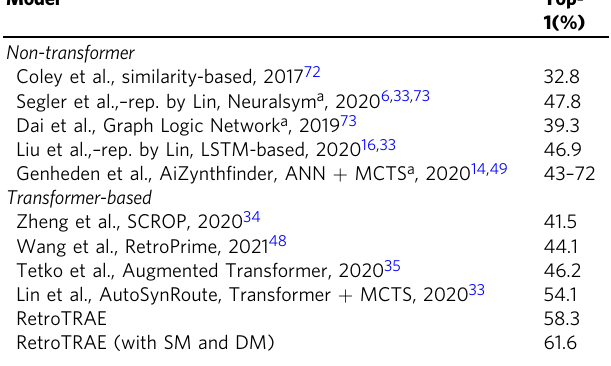
Fig. 5 Area-proportional Euler graph representing the space of atomic environments. The following databases are used: PubChem 110 M, ChEMBL 2.08 M (ChEMBL v28, as of May 2021), and USPTO fully atom- mapped 500 K reactions ( ∼ 1.3 M molecules). AE0 is upscaled by 20 times for better visual interpretation.